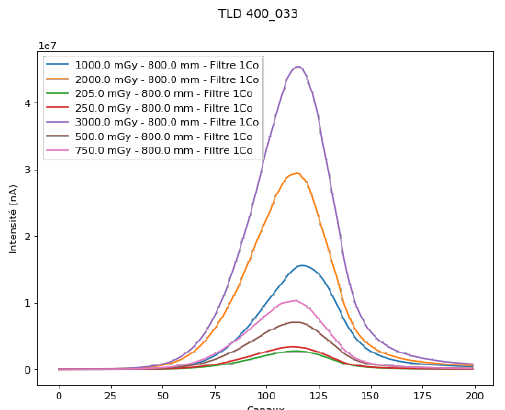
Fig. 3. Luminescence curves at different doses for a TLD400 after irradiations carried out for the calibration phase (“ Filtre 1Co ”: measurement with 100%- transmittance filter, irradiation in front of a cobalt source).